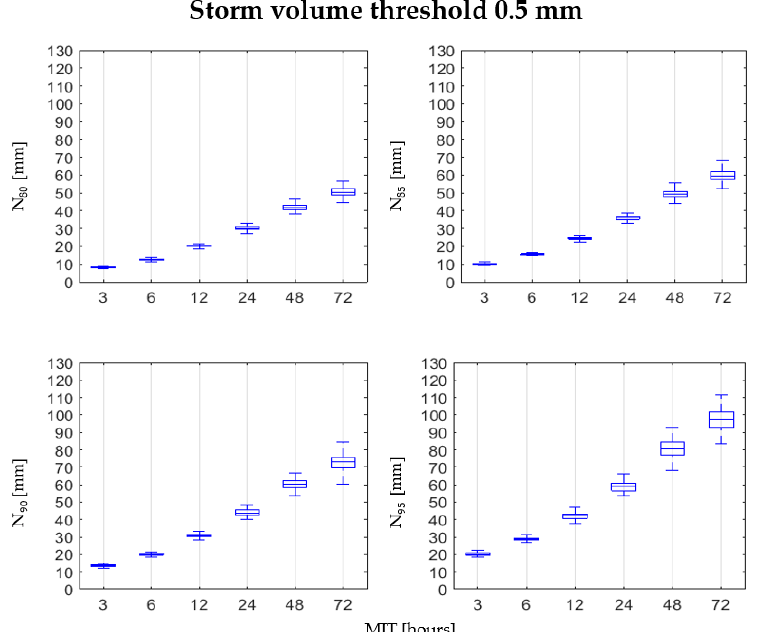
Figure 8. Effect of different MITs on values of volumetric percentiles that treat a percentage of the total number of rainfall events, for simulated rainfall series and a fixed 0.5 mm value of storm volume threshold.